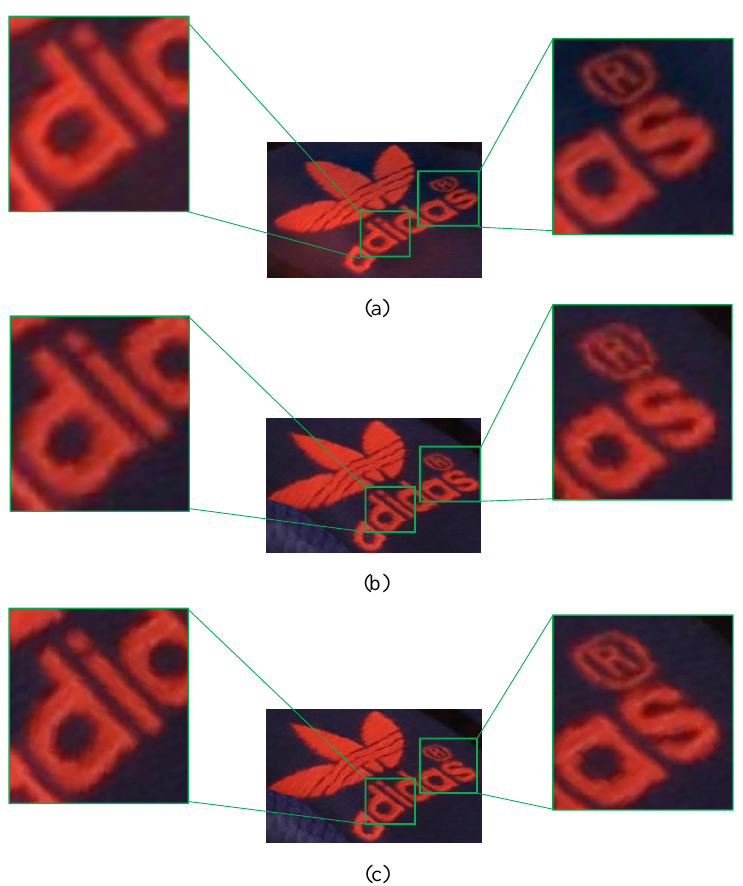
Figure 13. The comparison of texture quality for three cases: ( a ) 3DSOM software, ( b ) 4096 × 4096/AABB and ( c ) 8192 × 8192/OBB.